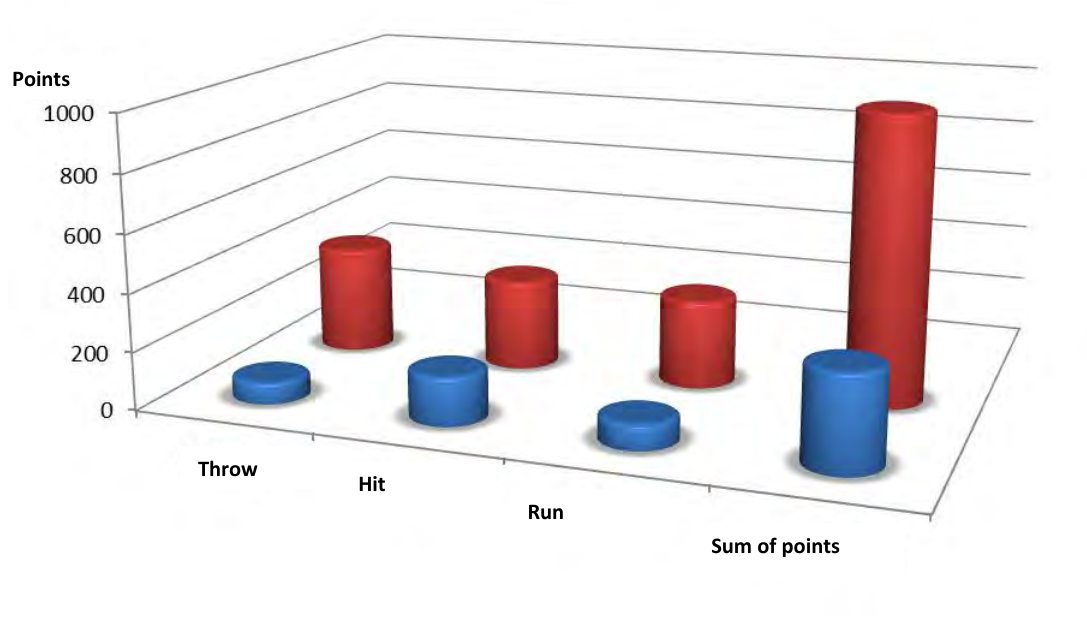
Fig. 2. Technical preparedness level of experimental group baseballers (n=50) before and after